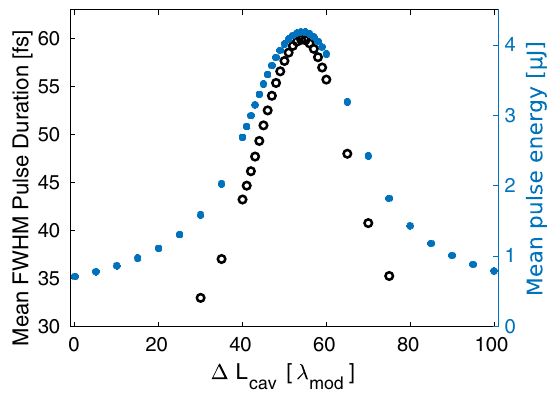
FIG. 3. Mean pulse energy and pulse duration over 30 passes in the oscillator for different cavity detuning Δ L modulator is tuned to λ